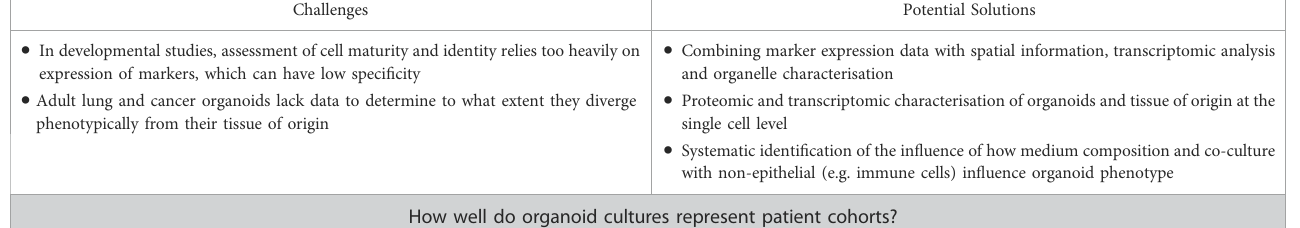
How closely do lung organoids recapitulate their tissue of origin? Challenges Potential